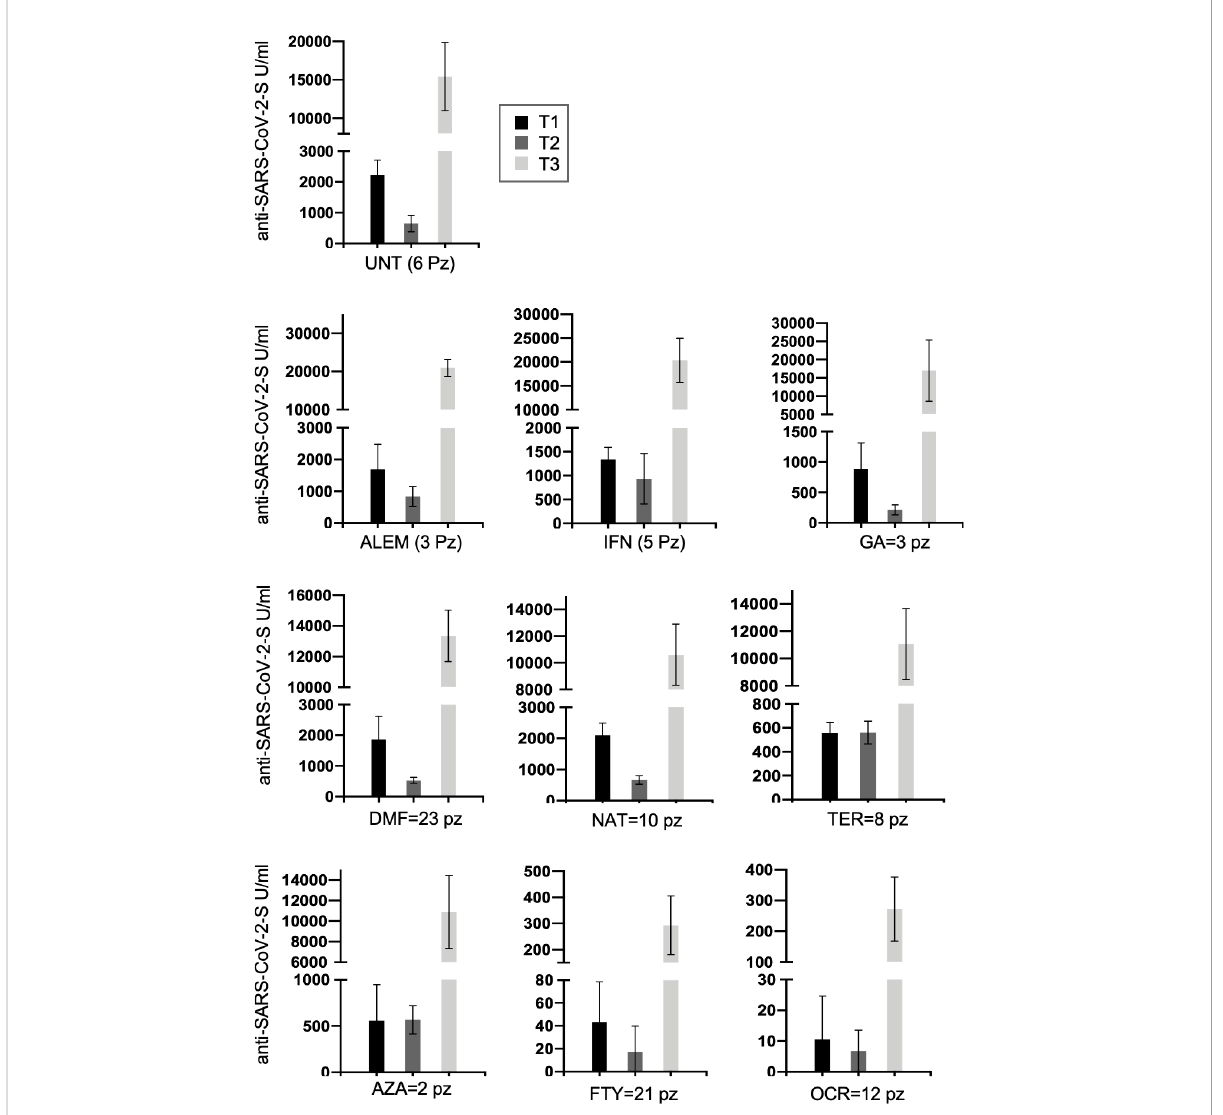
FIGURE 4 Longitudinal humoral response over time (T1, T2 and T3) in 94 MS patients treated with different DMTs or untreated and present at each time point. Post-vaccination anti-S antibody response by disease- modifying therapy (DMT) in MS patients is represented longitudinally. Results are represented as histogram showing the median value. (UNT, untreated; ALEM, alemtuzumab; IFN, interferon; GA, glatiramer acetate; DMF, dimethyl fumarate; NAT, natalizumab; CLA, cladribine; TER, teri fl uomide; AZA, azathioprine; FTY, fi ngolimod; RTX, rituximab; OCR, ocrelizumab; pz,